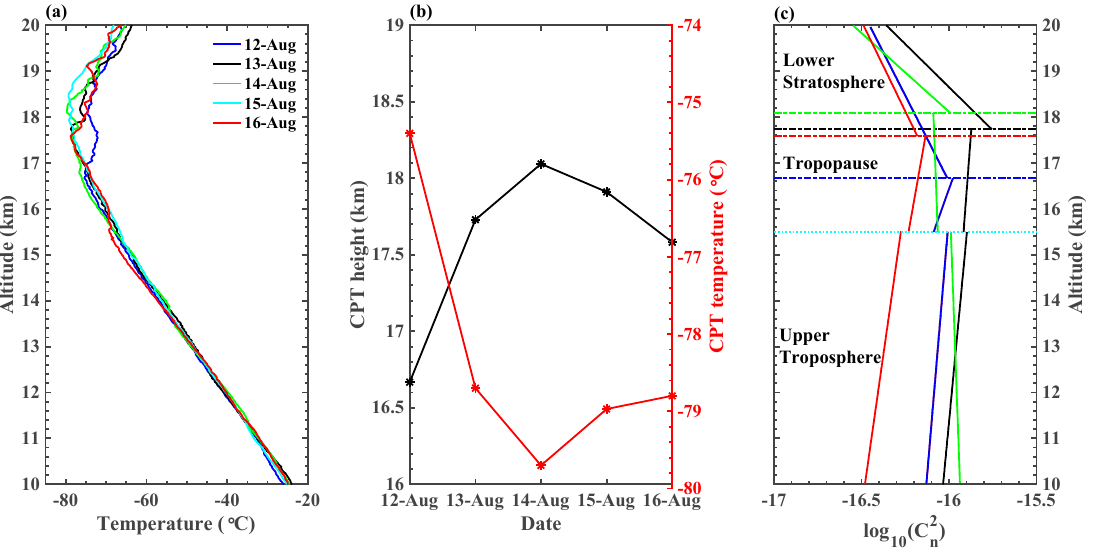
Figure 5. ( a ) Vertical temperature profiles from 12 to 16 August 2018. ( b ) Cold-point tropopause height (the black line) and temperature (the red line) from 12 to 16 August 2018. The lowest layer of the multi-tropopause serves as the CPT height. ( c ) First-order linear piecewise fitting to log (cid:2869)(cid:2868) (𝐶 (cid:3041)(cid:2870) ) within the upper troposphere, tropopause, and lower stratosphere.